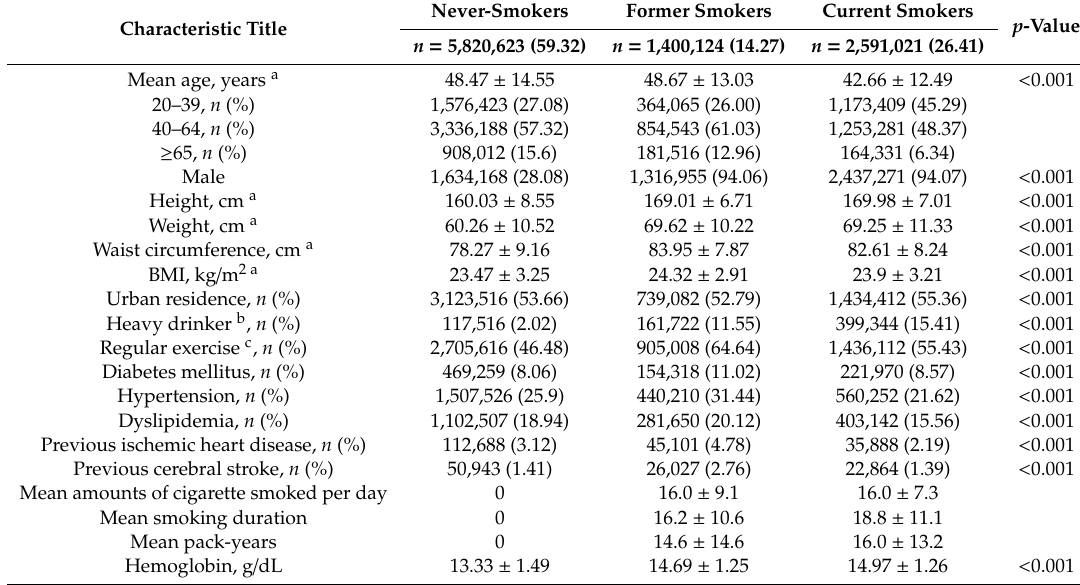
Table 1. Baseline characteristics of the study population according to smoking